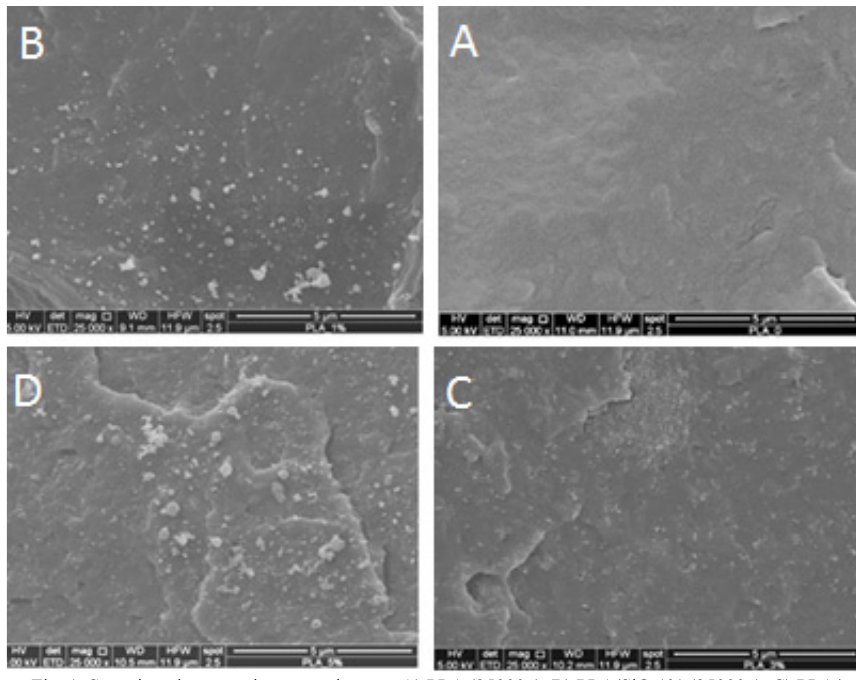
Fig. 1. Scanning electron microscopy images. A) PLA (25000x), B) PLA/SiO Fig 1 . Scanning electron microscopy images. A) PLA (25000x), B) PLA/SiO 2 1% (25000x), C) PLA/SiO 2 3% (25000x), D) PLA/SiO 2 5% (25000x)